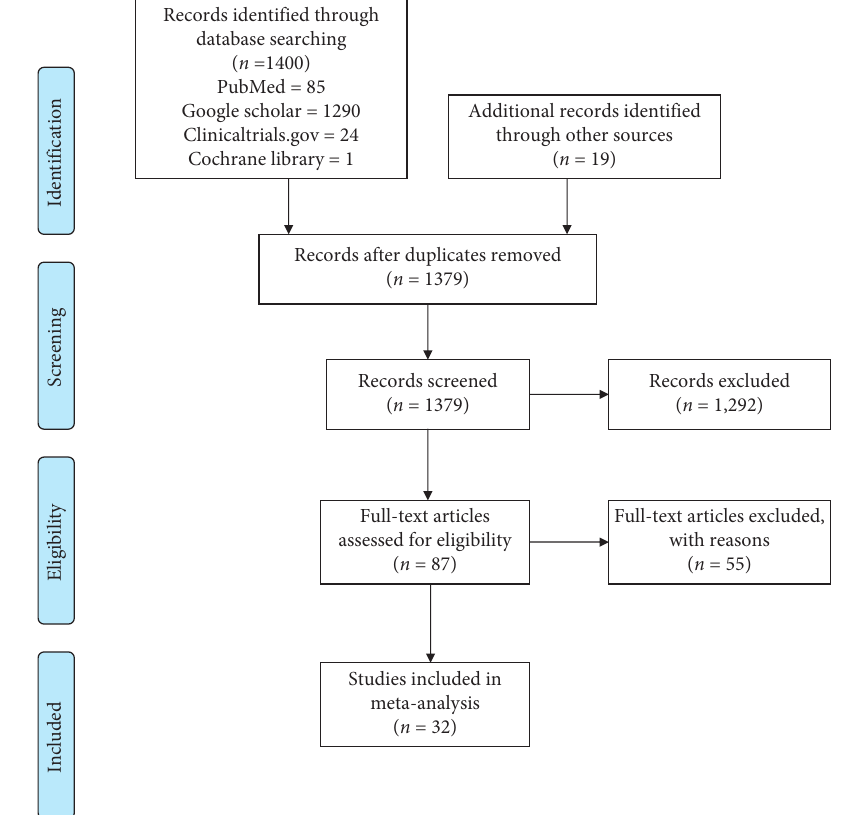
Figure 1: PRISMA study flow diagram. Table 1: Characteristics of included